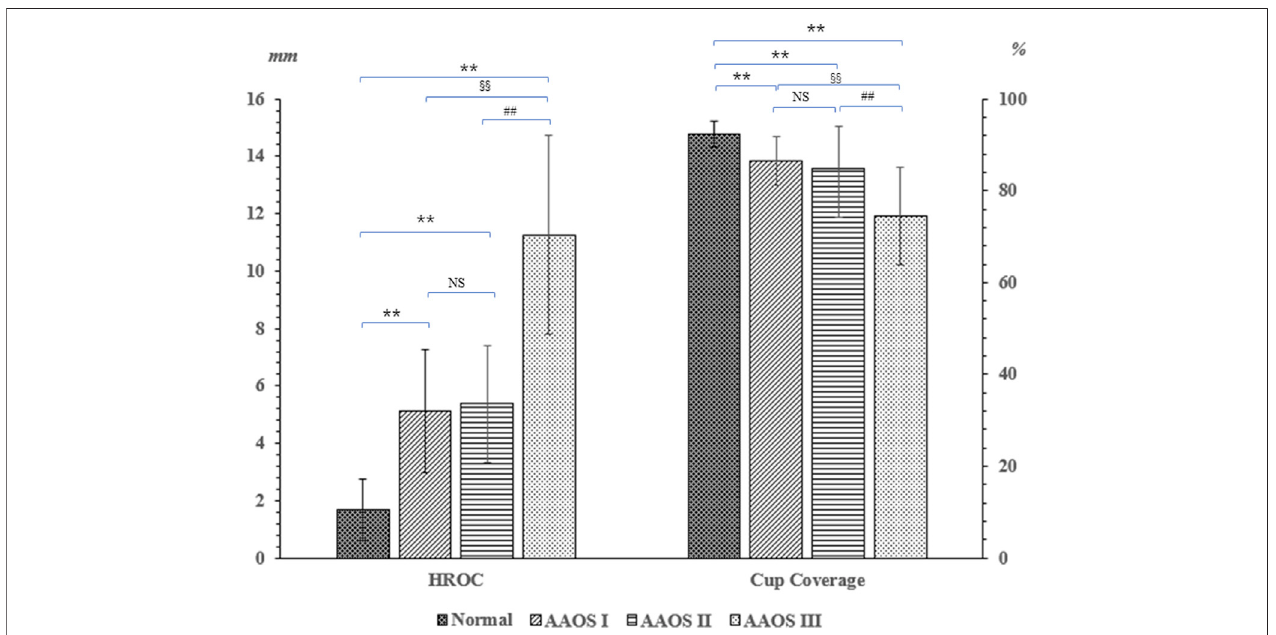
FIGURE 3 | Comparison of the implanted acetabular cup hip rotation of center elevation and cup coverage in the control and AAOS I – III groups. Represents compared with the control group with p < 0.05, ** Represents p < 0.01. # p < 0.05 represents the statistical difference between the AAOS II and AAOS III; ## Represents p < 0.01. § p < 0.05 Represents the statistical difference between the AAOS I and AAOS III; §§ Represents p < 0.01.